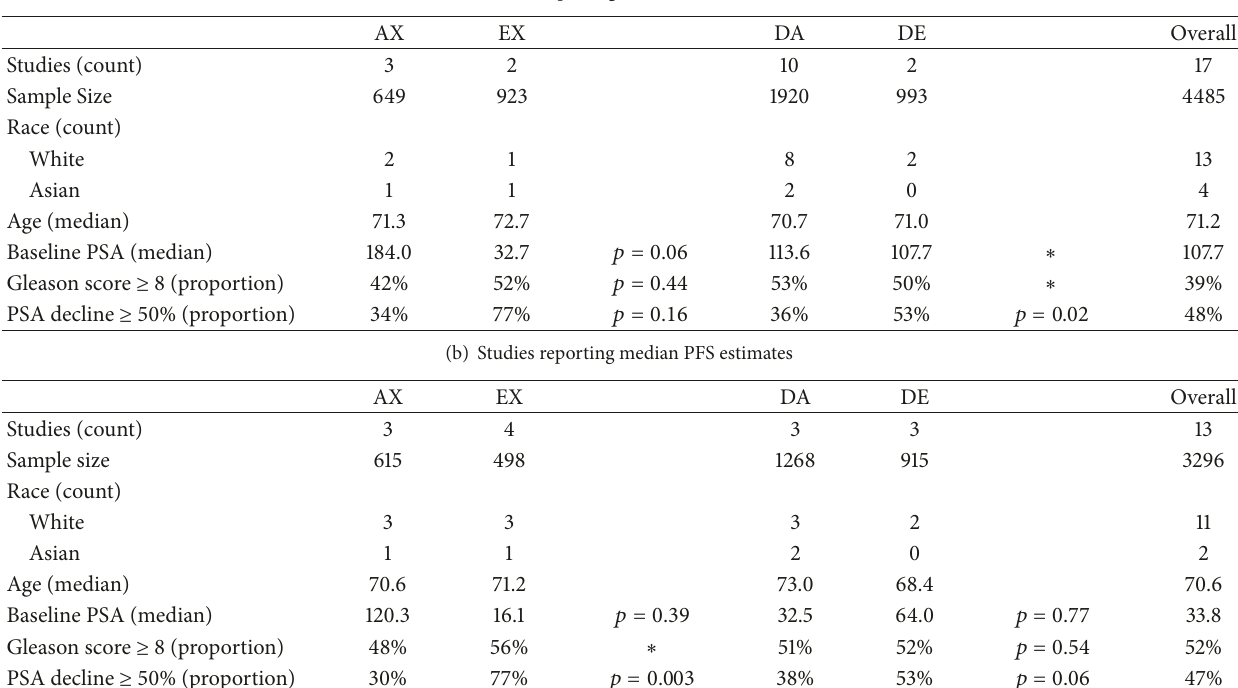
Table 2: Baseline patient characteristics.